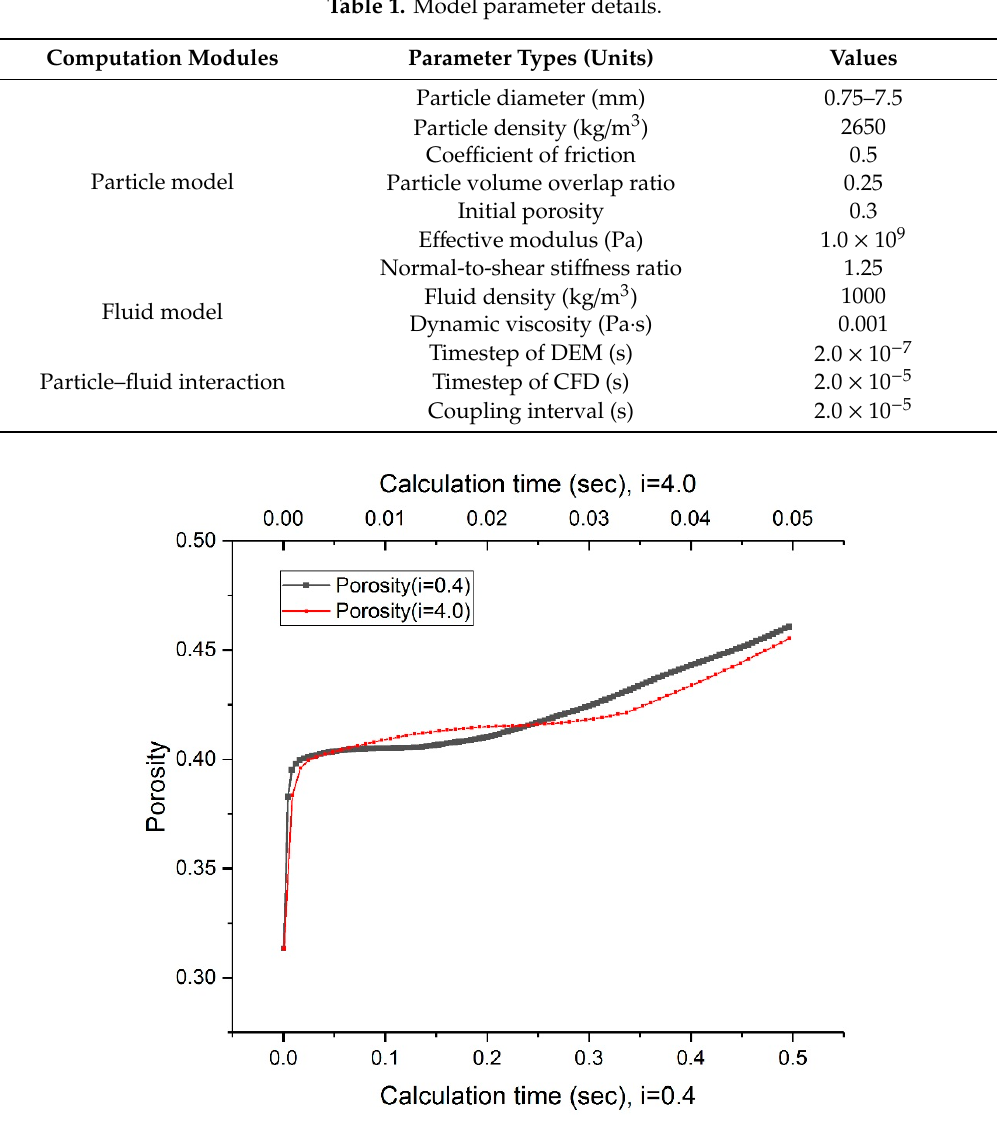
Figure 10. Porosity of the test model under different hydraulic gradients.